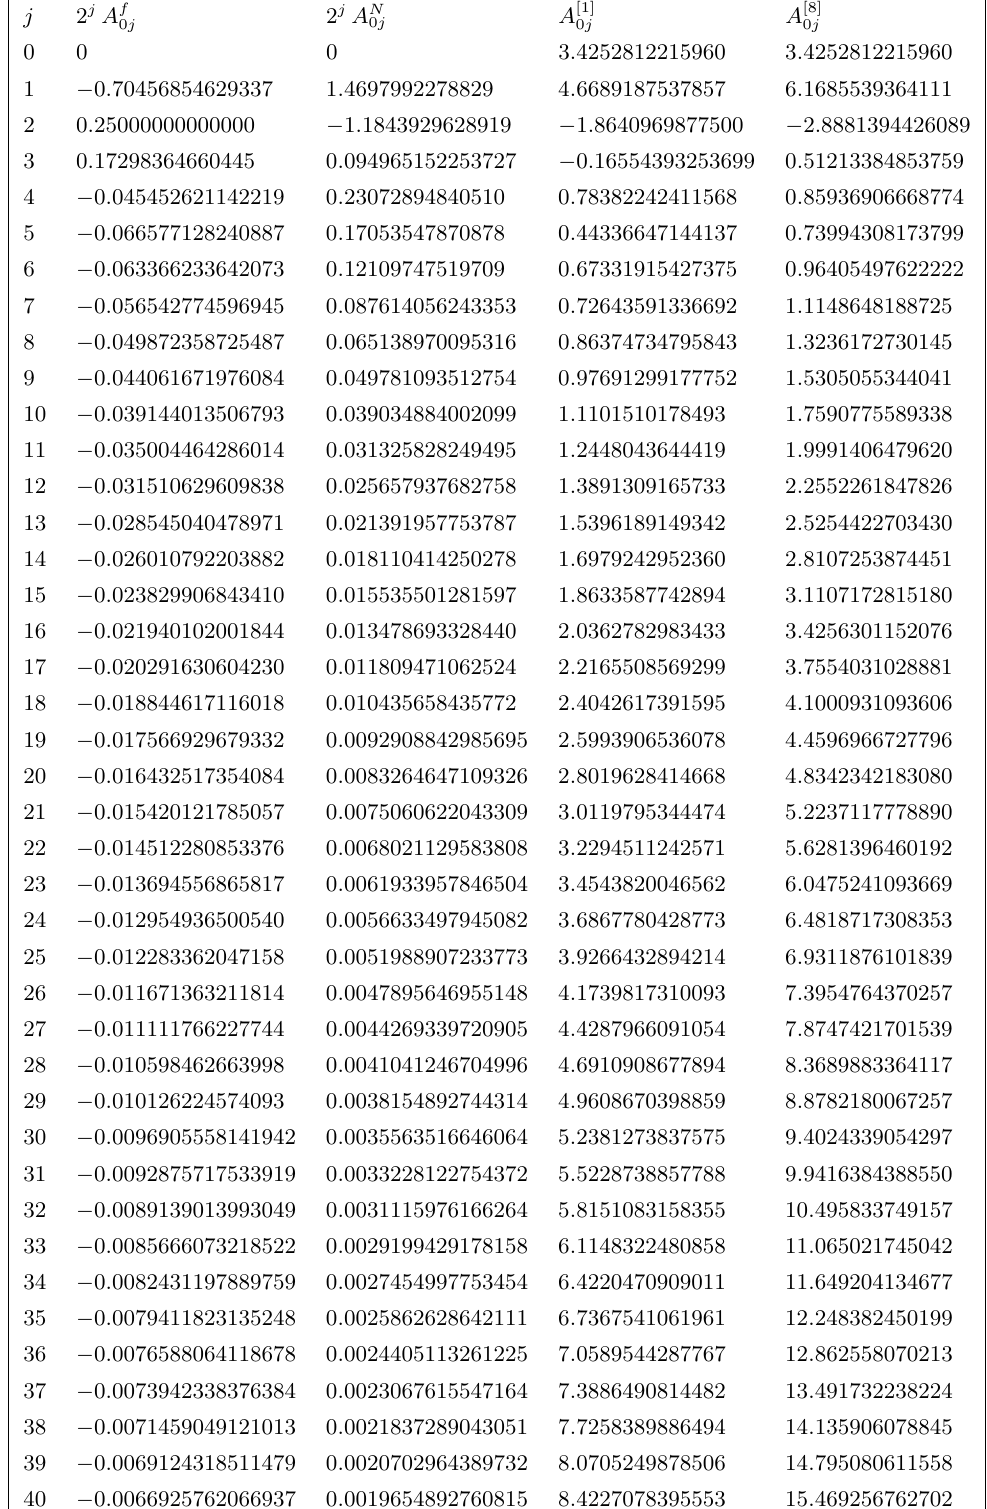
Table 5 . Coe(cid:14)cients of the term including ln 0 ( z ) in the asymptotic expansion at z = 0.